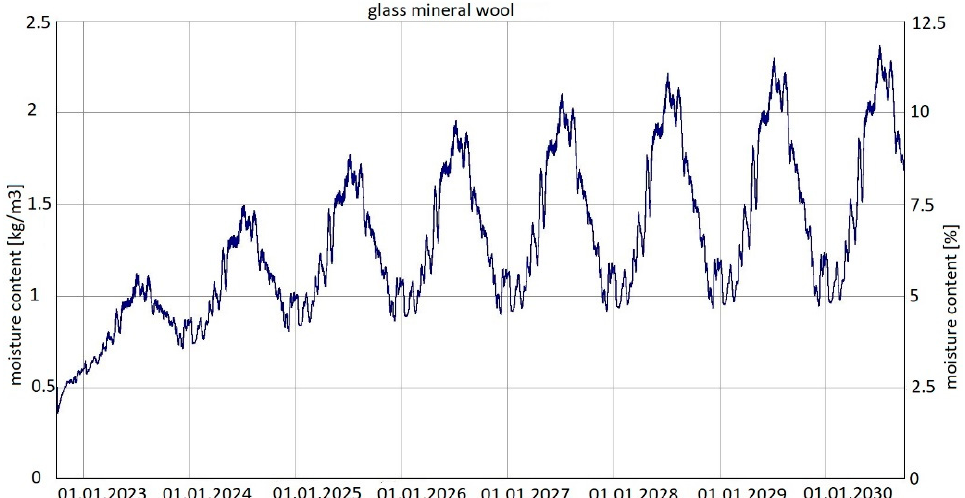
Figure 15. Changes in moisture content in glass mineral wool over eight years, variant 5 [70].